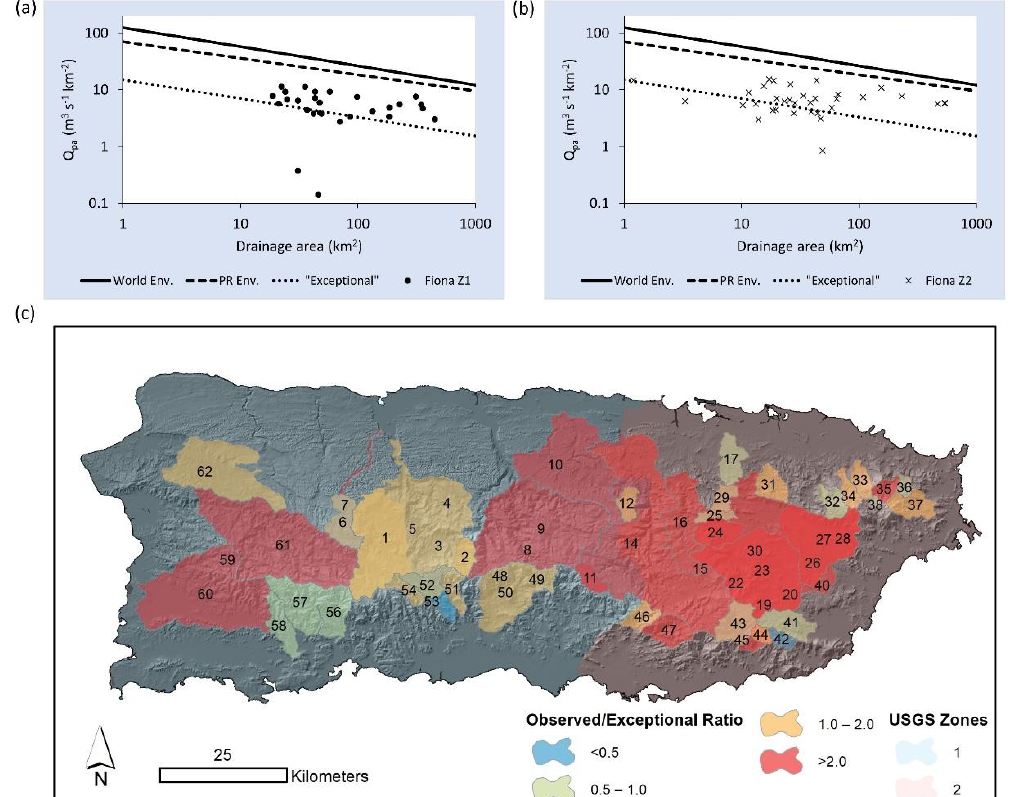
Figure 7. Watershed-by-watershed area-normalized instantaneous peak flow (Q pa ) during Hurricane Fiona. ( a ) Drainage area versus Hurricane Fiona Q pa values for watersheds in Puerto Rico’s Zone 1 (western zone) relative to exceptional flows (Equation (5)), the world flood envelope (Equation (6)), and Puerto Rico’s flood envelope (Equation (7)). ( b ) Drainage area versus Hurricane Fiona’s Q pa values for watersheds in Puerto Rico’s Zone 2 (eastern zone) relative to exceptional flows, and the world’s and Puerto Rico’s flood envelopes. ( c ) Watershed-by-watershed distribution of Q pa / Q pa excep ratios for Hurricane Fiona.